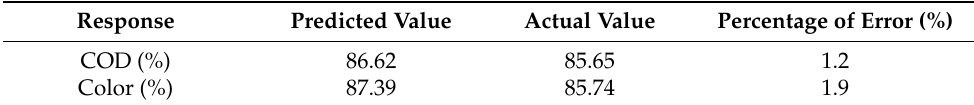
Table 5. Comparison between predicted and actual laboratory